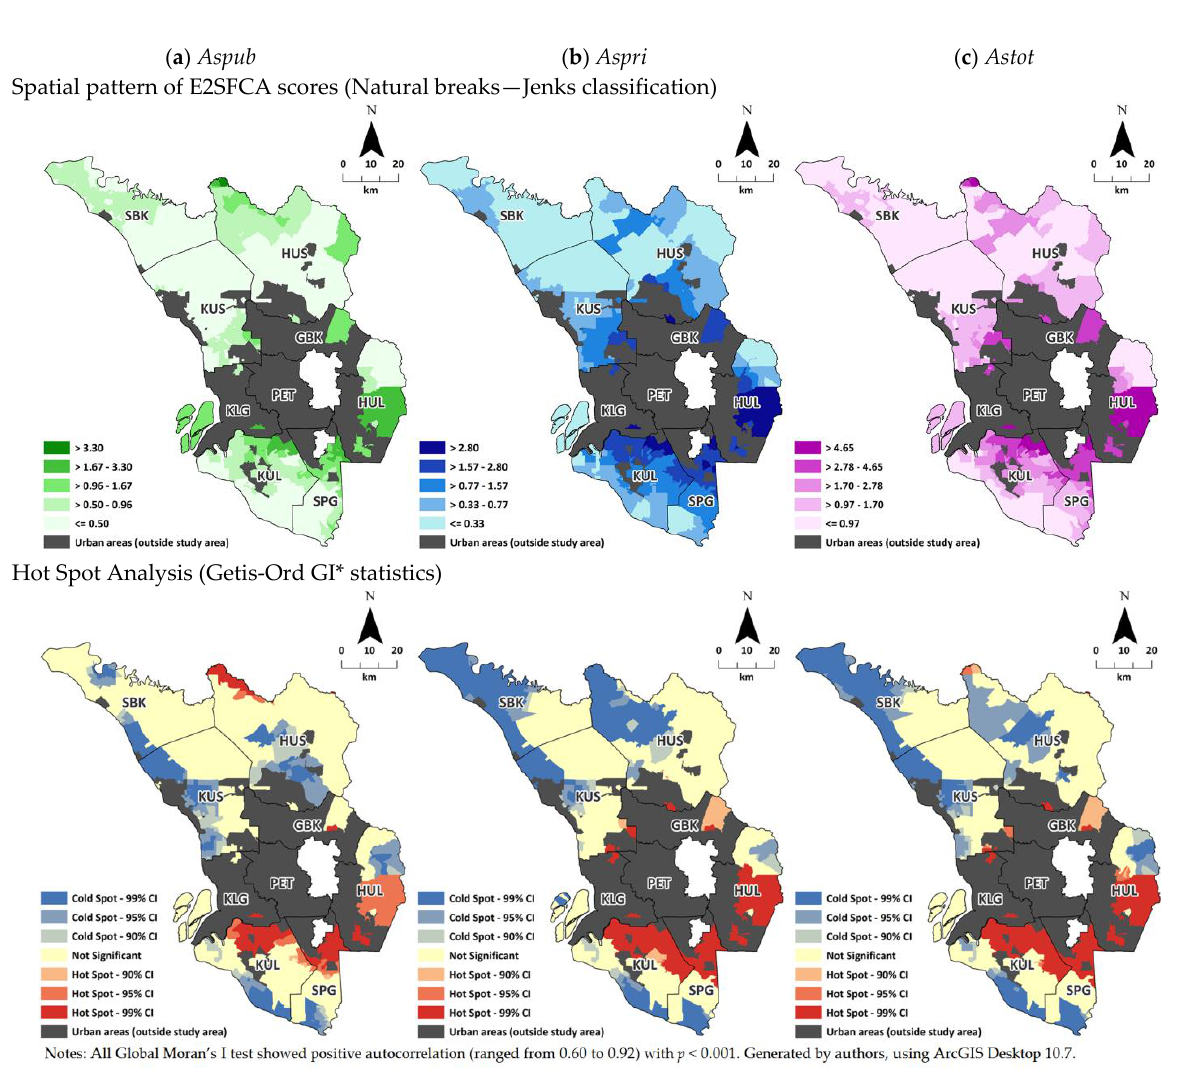
Figure 2. Spatial pattern of E2SFCA scores distribution and mapping of Hot Spot Analysis of the E2SFCA scores ( a ) Aspub score, ( b ) Aspri score, and ( c ) Astot score.